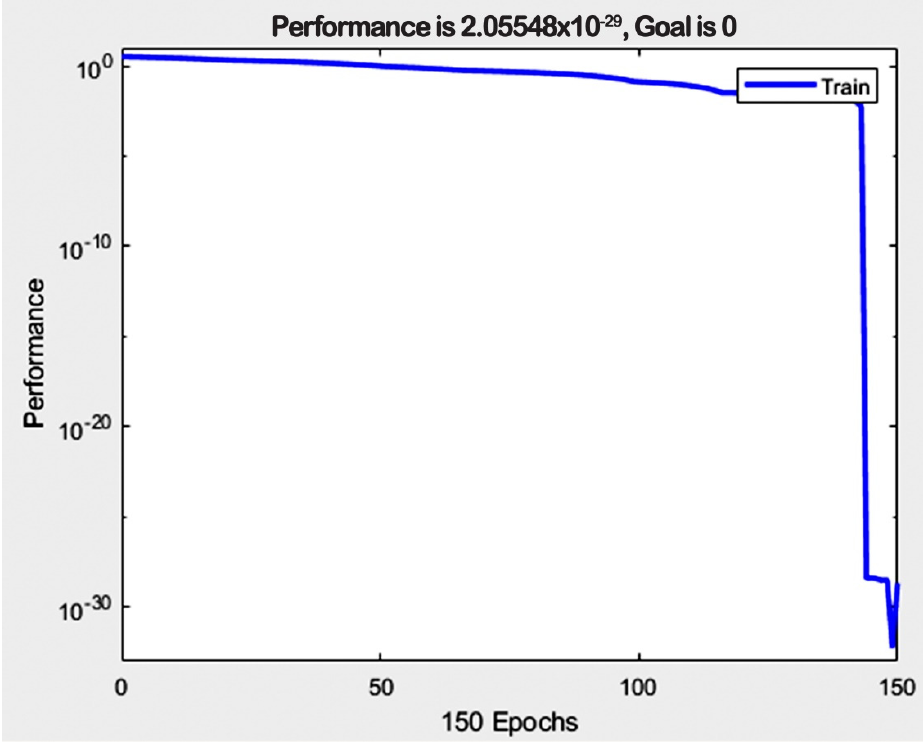
Figure 9. Performance of training for Duval_Triangle_5_RBFNN.